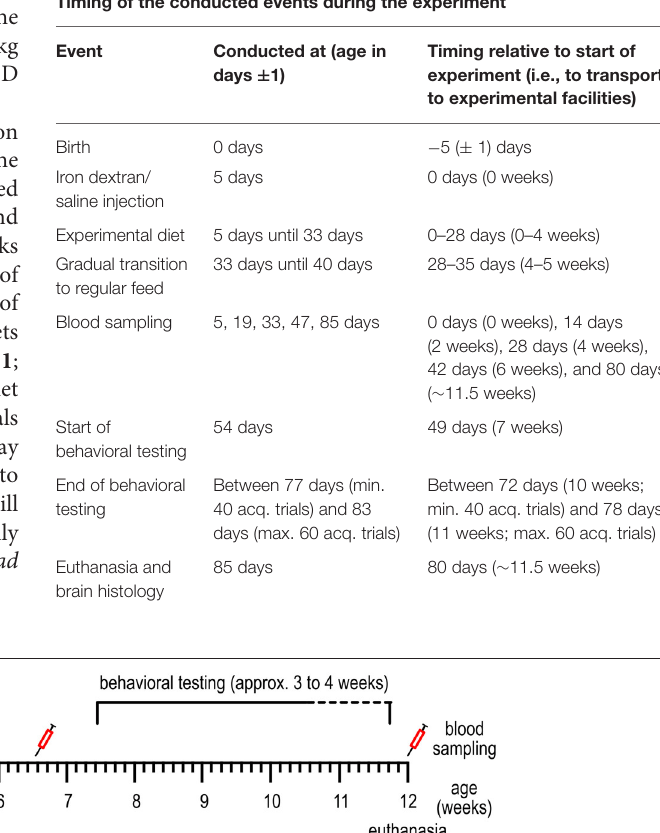
TABLE 1 | The timing of events conducted during the experiment, relative to the birth of the piglets (middle column) and relative to weaning and the start of the experimental diets (right column).